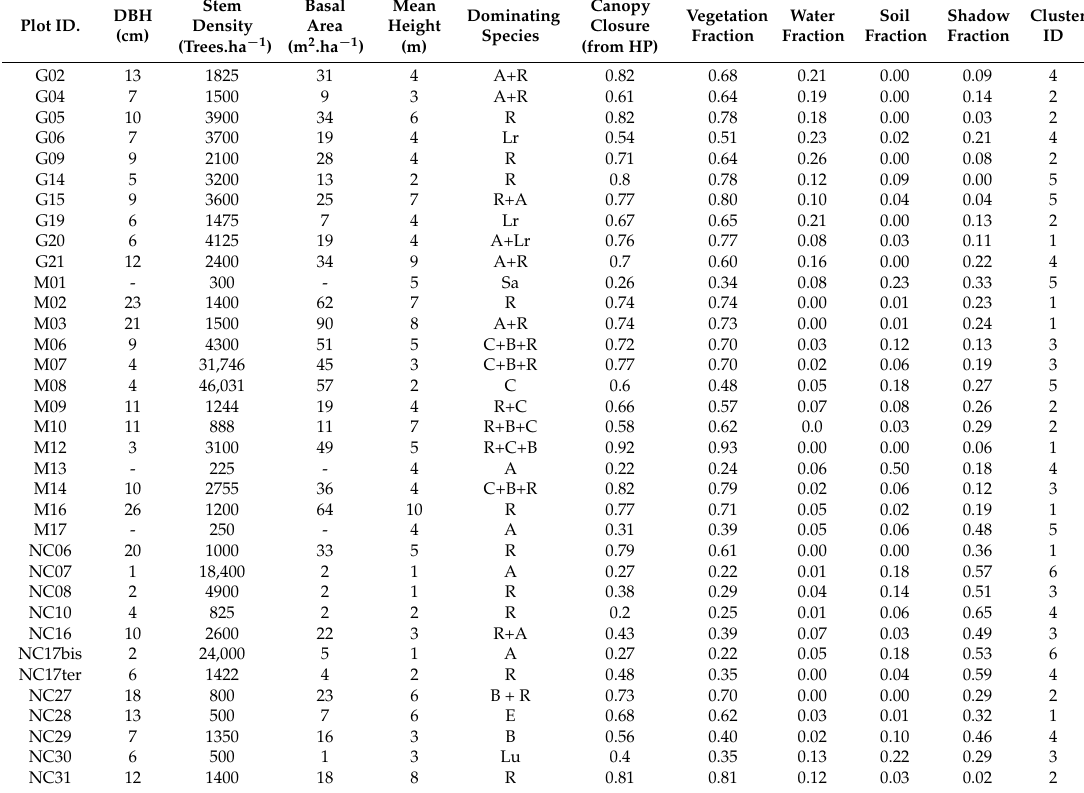
Table 1. Ground data with the main forest parameters and canopy closure estimated from hemispherical photographs (HP) for all plots in the three sites (G: Guadeloupe; M: Mayotte; NC: New Caledonia). The DBH and basal areas represented by “-” are for multi-stem trees. Cluster ID column must be interpreted after the reading of the method and result sections. R = Rhizophora sp.; A = Avicennia sp.; Lr = Laguncularia racemosa ; B = Bruguiera sp.; E = Excoecaria agallocha ; Lu = Lumnitzera racemosa ; Sa = Sonneratia alba ; C = Ceriops